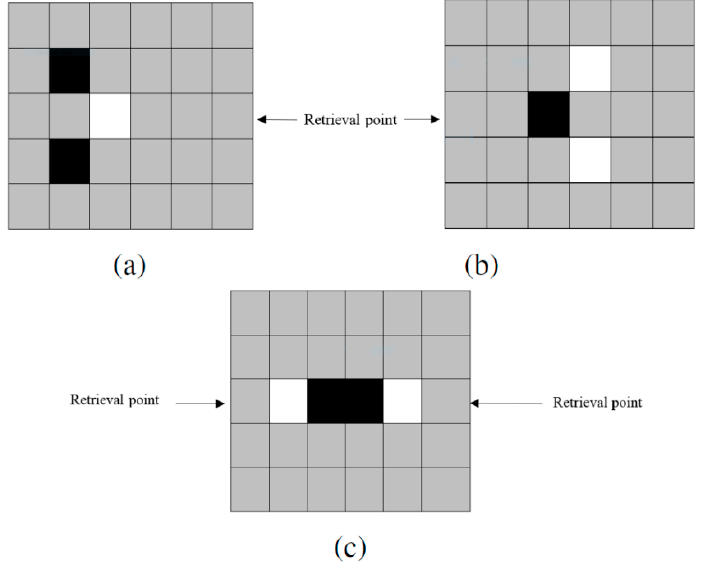
Figure 7. Deadlock prevention situations. ( a ) Deadlock Type 1; ( b ) Deadlock Type 2; ( c ) Deadlock Type 3.